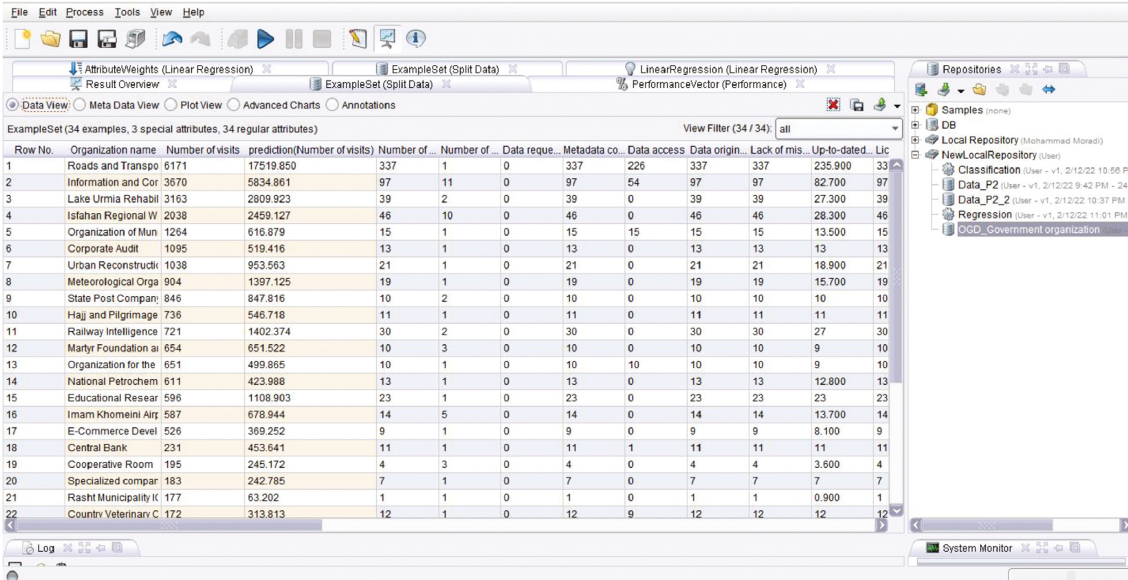
Figure 9: Test data with the predicted value of the label and the actual value of the label.